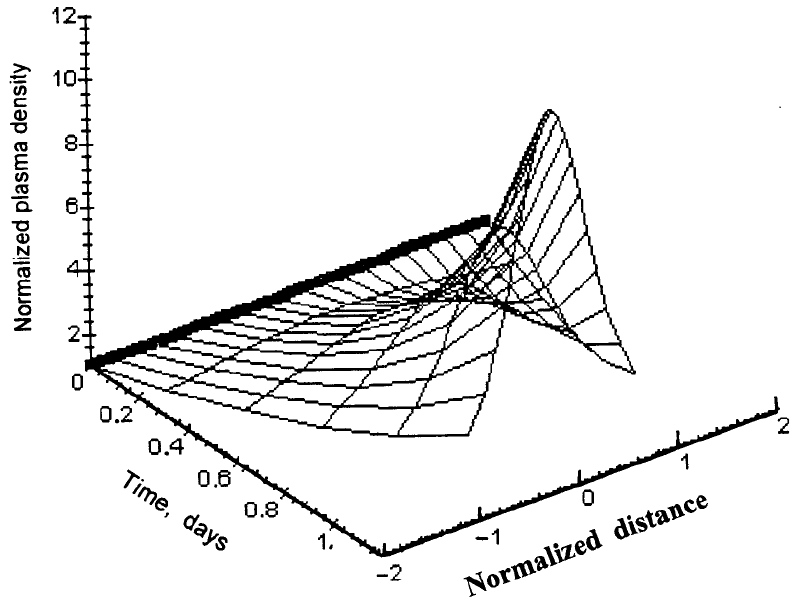
Fig. 3. Non-steady-state numerical solutions showing horizontal, metallic ion, plasma accumulation across a PW cyclonic vortex. It refers to 120km and applies for a quasi 2-day PW having a typical cyclonic scale size λ υ ∼ 5 × 10 3 km and a wave amplitude U = 25m/s. The x -axis label “normalized distance” refers to the radial distance from the vortex center divided by λ υ . As seen, after about 1 day, the plasma density in the central vortex areas increases up to about an order of magnitude above the background electron